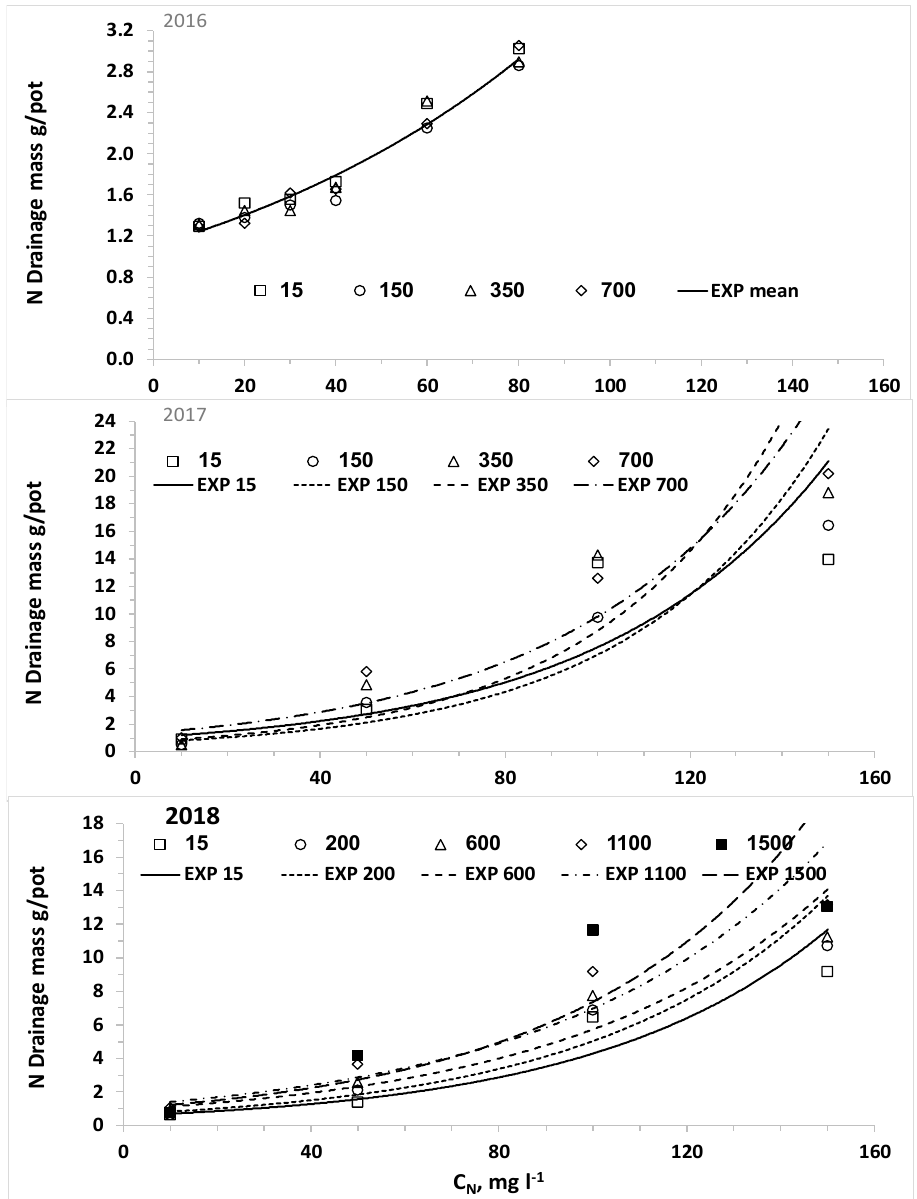
Figure 5. Nitrogen mass in the leachate of three potato experiments: 2016, 2017, and 2018. The equations of best fit curves of N-Drainage mass (M NL ) vs. N irrigation concentration (C N ) are presented in Figure 5 as follows: 2016, mean, Y = 1.1008e0.0122x, R2 = 0.975. 2017, 15, Y = 0.9752e0.0205x, R2 = 0.882. 2017, 150, Y = 0.631e0.0241x, R2 = 0.896. 2017, 350, Y = 0.7004e0.0253x, R2 = 0.839. 2017, 700, Y = 1.2692e0.0204x, R2 = 0.887. 2018, 15, Y = 0.5781e0.02x, R2 = 0.948. 2018, 200, Y = 0.6808e0.02x, R2 = 0.952. 2018, 600, Y = 0.9483e0.018x, R2 = 0.951. 2018, 1100, Y = 1.1867e0.0177x, R2 = 0.927. 2018, 1500, Y = 1.1015e0.0198x, R2 =